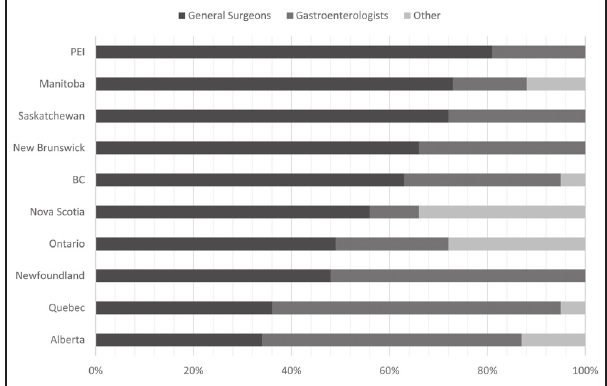
Figure 1) Provincial division of labour for the delivery of colonoscopy.